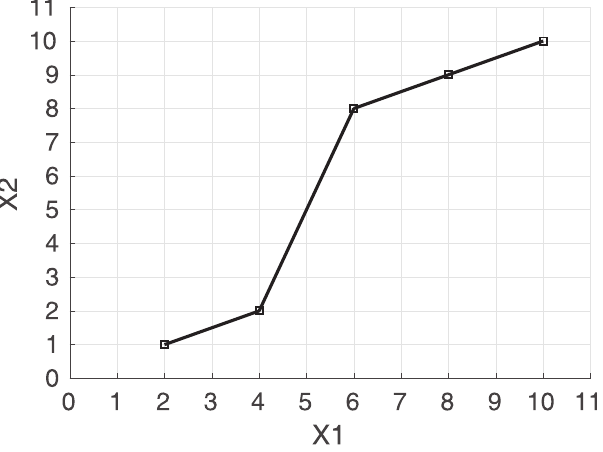
Fig 2. Path of a trajectory through R 2 where X 1 = {2, 4, 6, 8, 10} and X 2 = {1, 2, 8, 9, 10}. The path signature of degree 2 is {1, 8, 9, 32, 31, 41,